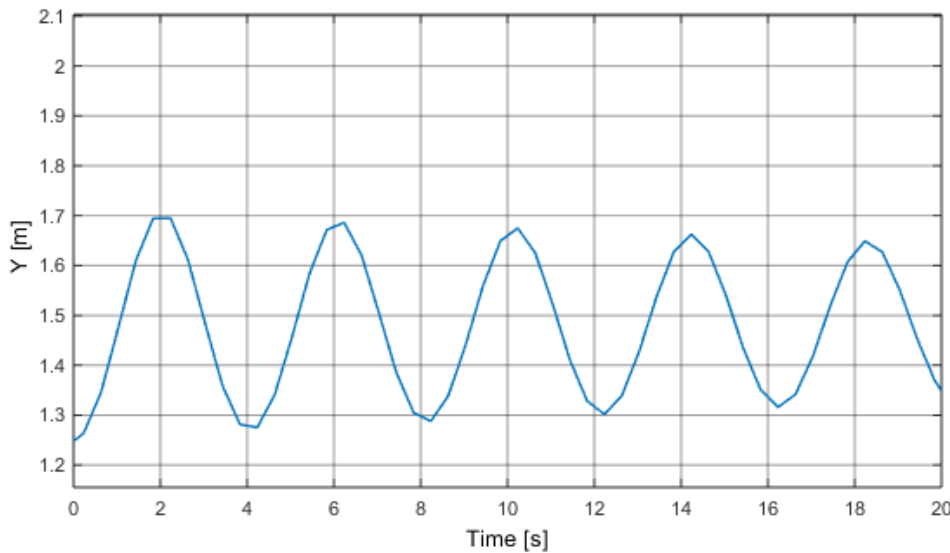
Figure 9. Oscillation response of the robot in the presence of 3 N forces in the upper cables. The PID parameters shown in Equation (8), resulted in Kp = 0.6, Tr = 2, and Td = 0.5. These constants were configured in the two control blocks shown in the structure of Figure 3, which, including the gravitational forces compensation stage, remains as shown in Figure 10.